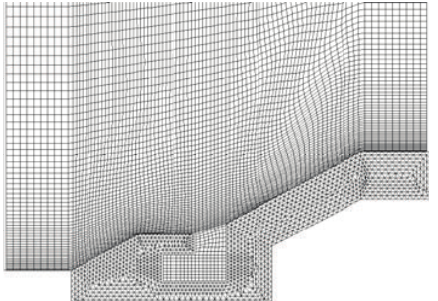
Figure 5: Mesh for the simulation of thermal coupling in a flap region.